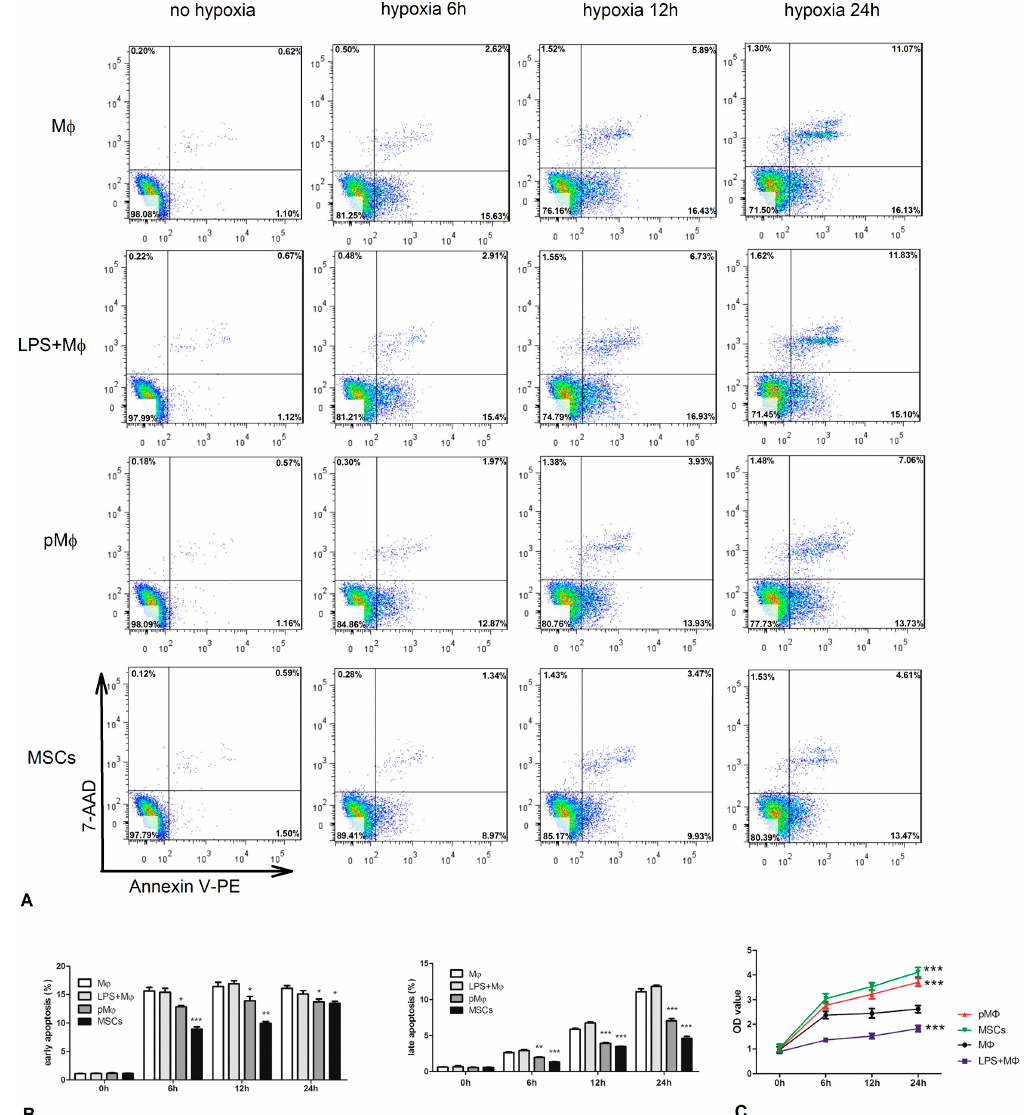
Figure 4. Cell counting kit-8 (CCK-8) proliferation assay and Annexin V-PE/7-ADD detected by